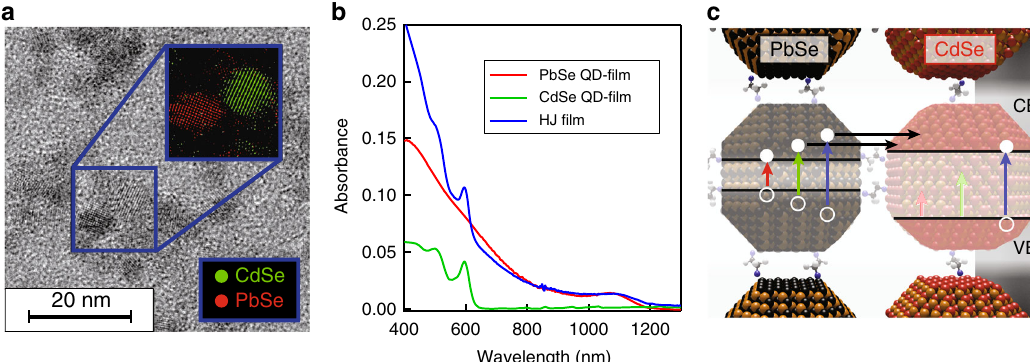
Fig. 1 Film properties. a High-resolution transmission electron microscope (TEM) image showing PbSe and CdSe quantum dots (QDs) drop-casted on a TEM grid and subsequently treated with 1,2-ethanedithiol (EDT). The inset displays the result of a Fourier bandpass analysis of the image, distinguishing the two QD materials via their atomic lattices, and showing close proximity between the two components. b Linear absorption spectra of the combined PbSe-CdSe QDHJ fi lm and of the single material fi lms. c Schematic of the energy alignment in the